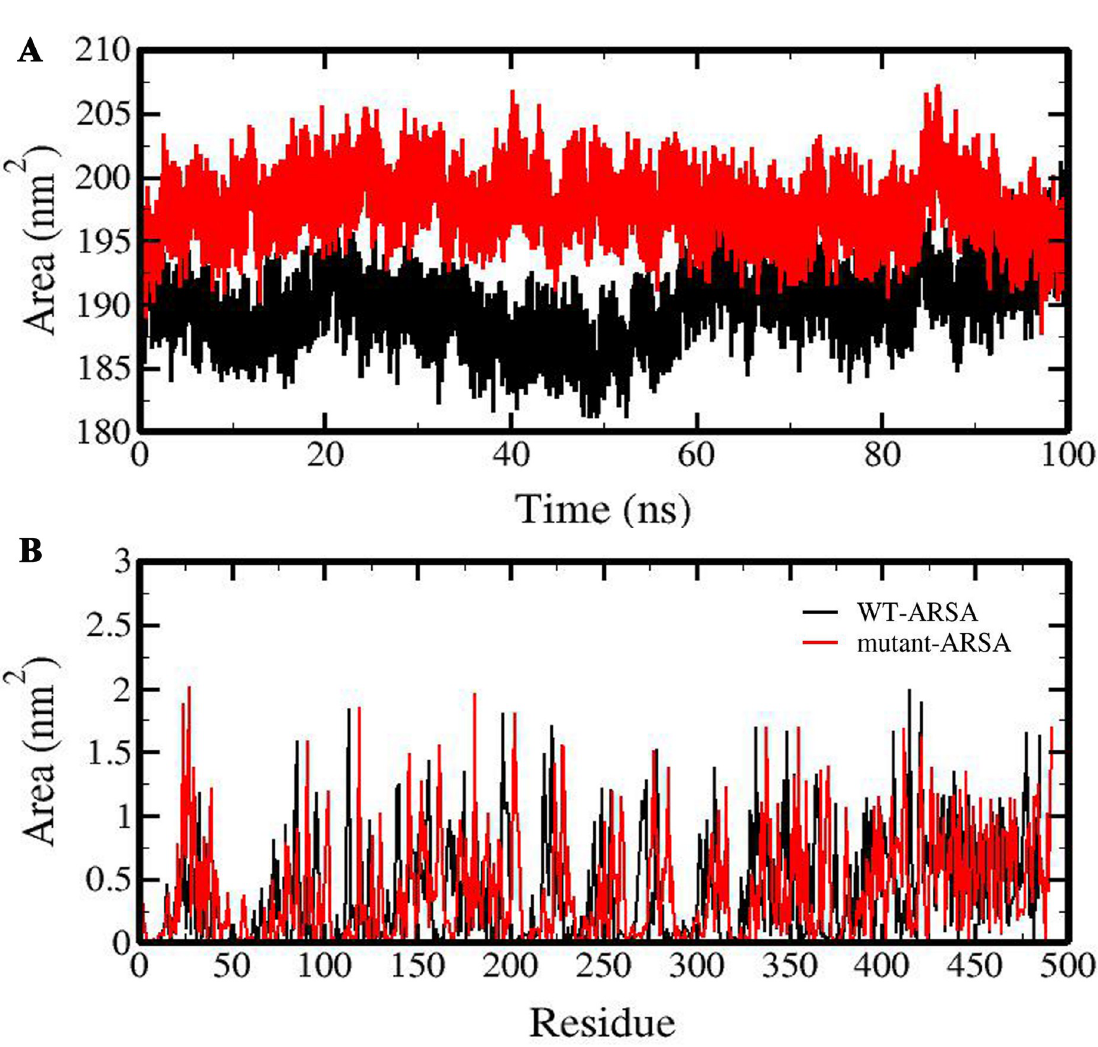
Fig 4. Graphical representation of solvent accessible surface area (SASA) of ARSA proteins. (A) Total SASA and (B) active site SASA of WT-ARSA and